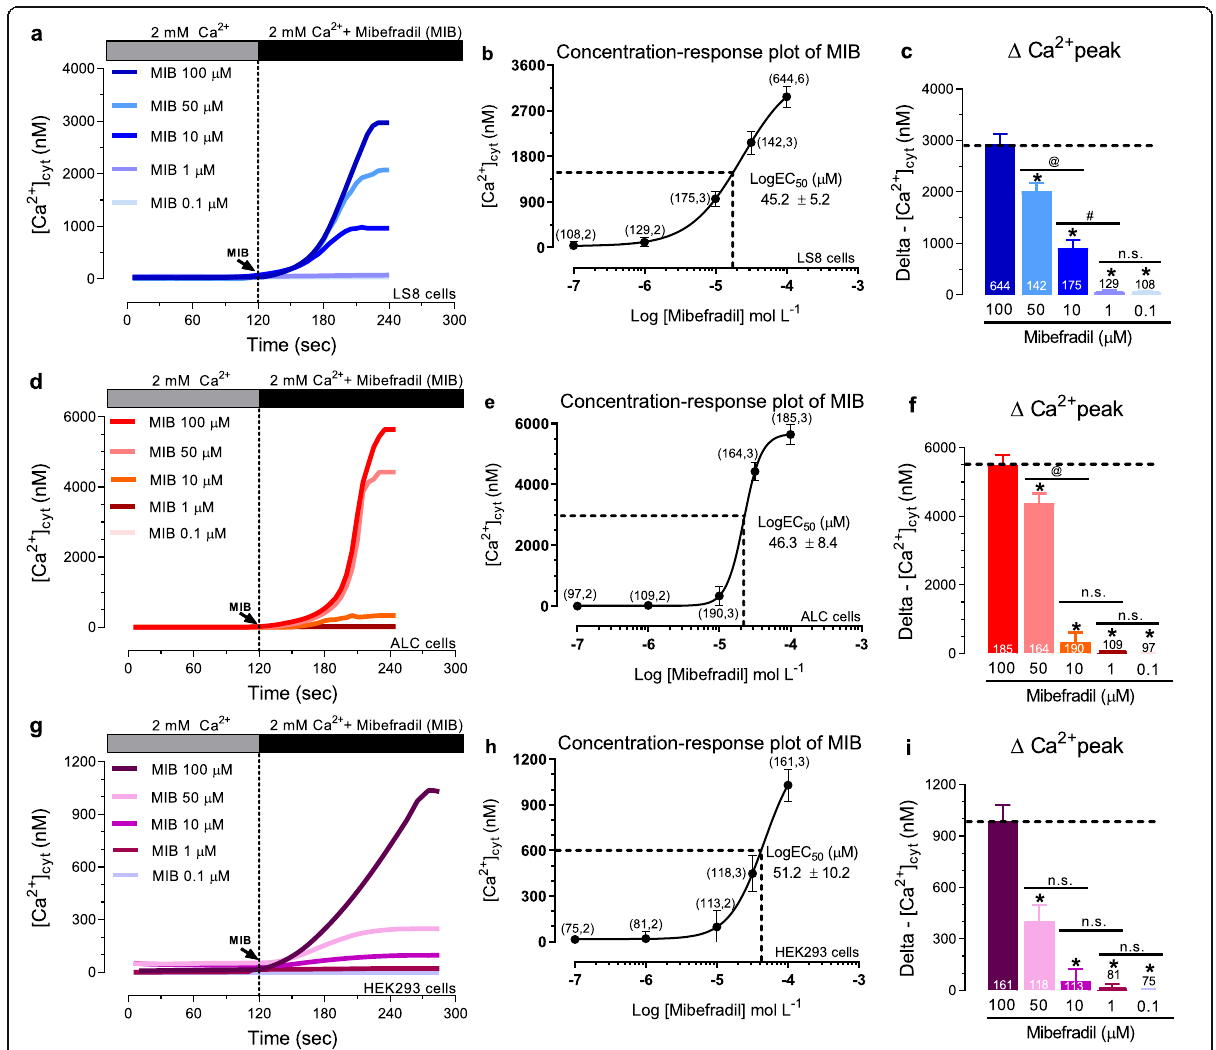
Fig. 1 Effects of mibefradil on [Ca 2+ ] cyt transients in LS8, ALC, and HEK-293 cells. a [Ca 2+ ] cyt transients in LS8 cells stimulated with mibefradil (0.1 μ M to 100 μ M) in the presence of 2 mM extracellular Ca 2+ . b LogEC 50 (apparent affinity) plot. c Quantification of Δ Ca 2+ peak. d-f Same as in a- c but measured in ALC cells. g-i Same as a-c but measured in HEK-293 cells. In all cells, traces show basal (0 – 120 s) Ca 2+ levels and the maximum capacity of Ca 2+ mobilization (240 – 300 s) at 100 μ M. Data represent the mean ± SEM of ≥ 75 cells from 3 independent experiments. Data were analyzed by one-way ANOVA followed by Tukey ’ s multiple comparison post-hoc test. * P < 0.05 vs. MIB-100 μ M group; @ P < 0.05 vs. MIB-50 μ M group; # P < 0.05 vs. MIB-10 μ M group; n.s.,